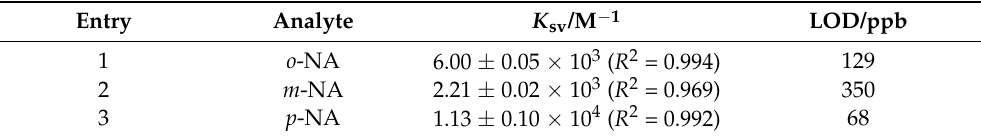
Table 5. Stern–Volmer constants of NA quenching of C-dots and their LOD 1 . Entry